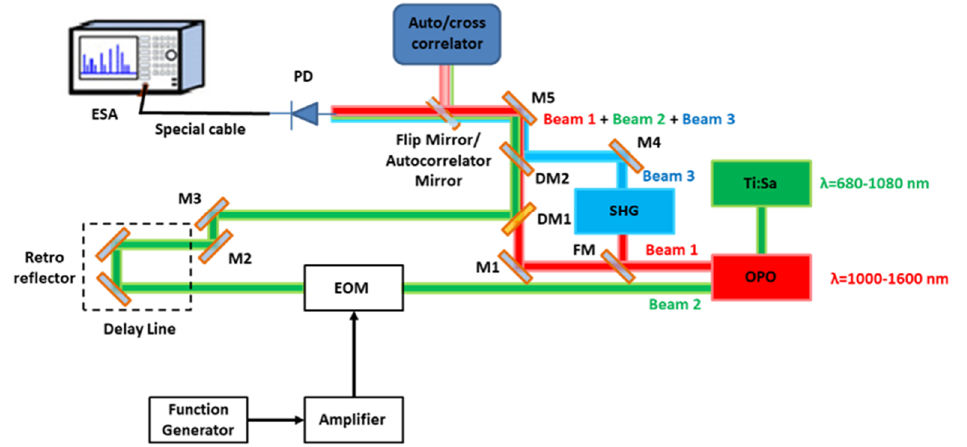
Figure 2. Experimental setup for femtosecond laser sources characterization. Ti:Sa = Ti:Sa laser; OPO = optical parametric oscillator; SHG = second harmonic generation; M1-M5 = femtosecond mirror; FM = flip mirror; DM1, DM2 = dichroic mirror; EOM = electro-optic modulator; PD = photodiode; ESA = electronics spectrum Analyzer.